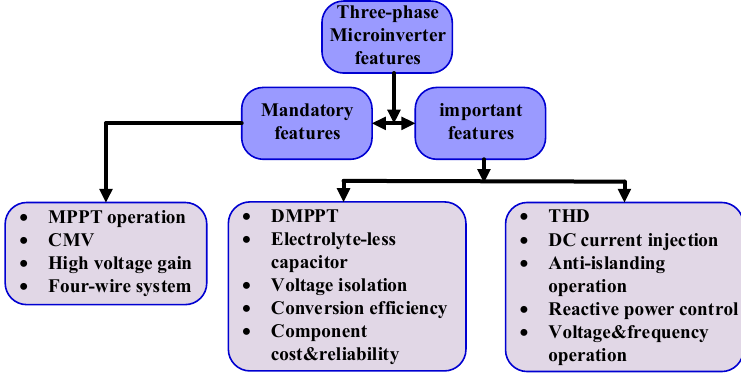
Figure 5. The main remarkable features of a three-phase microinverter.